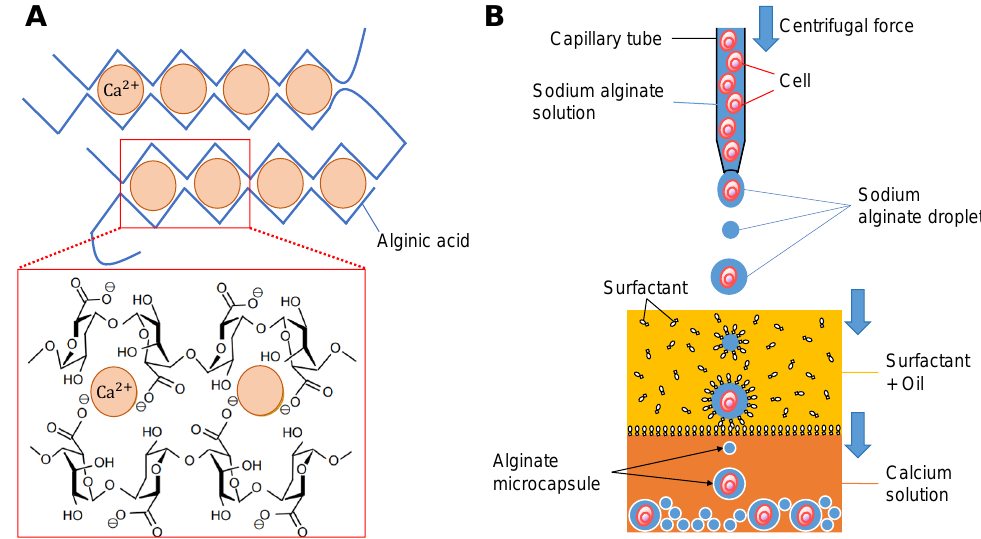
Figure 1. Principle of alginate microcapsule formation. ( A ). Schematic drawing of the change of soluble sodium alginate into insoluble calcium alginate. ( B ). Conceptual process of calcium alginate microcapsule formation. First, droplets of sodium alginate with/without cells are formed at the microcapillary tip with the pressure of centrifugal force. Then the droplets are introduced into the oil and coated with surfactants. Finally, the surfactant-coated droplets proceed to the calcium chloride solution and the surface of the sodium alginate droplet changes to insoluble calcium alginate as the alginate